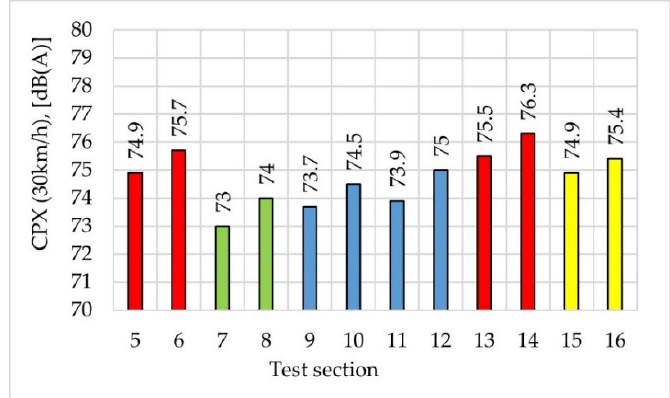
Figure 18. CPX index on test sections.